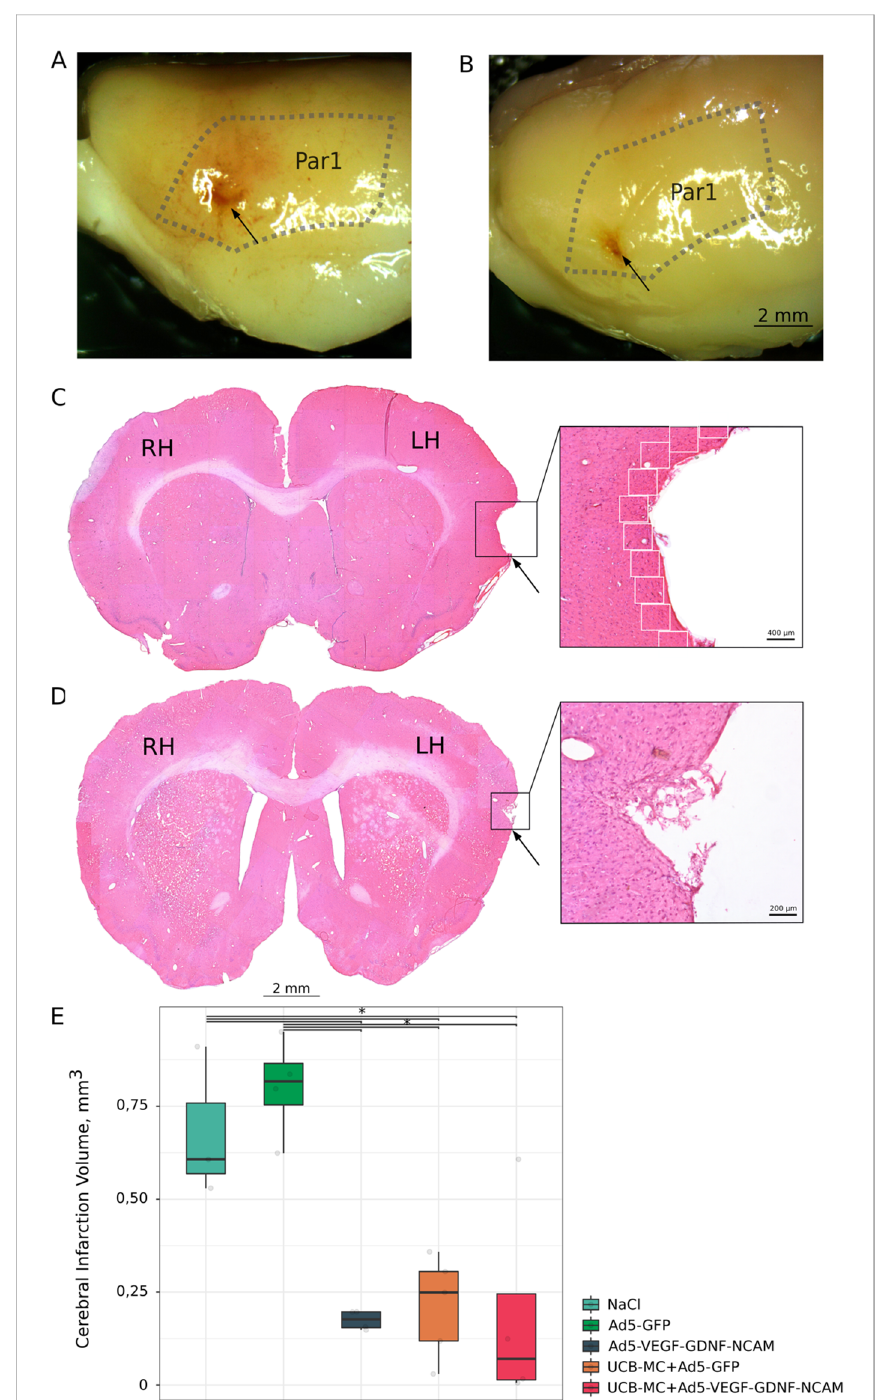
Figure 2. Ischemic stroke in rats 3 weeks after the distal middle cerebral artery occlusion. ( A , C )—The brain from the control (NaCl) group. ( B , D )—The brain from the therapeutic (UCB-MC+Ad5-VEGF-GDNF-NCAM) group. In ( A ) and ( B ) the stroke area in the parietal lobe of the brain is shown with the arrow. Par1—cortex parietals, area 1 is marked by a dotted line. In ( C ) and ( D )—frontal sections of the brain in the stroke area stained with hematoxylin and eosin. RH—right hemisphere; LH—left hemisphere. Inserts with arrows show the stroke area with the maximum depth and the maximum radius of the infarct cavities at higher magnification. White boxes in the insert in ( C ) panel indicate areas with S = 0.05 mm 2 in the peri-infarct zone used for immunofluorescent analysis. ( E )—comparative morphometric analysis of the infarct cavities volume in experimental groups; *— p < 0.05.